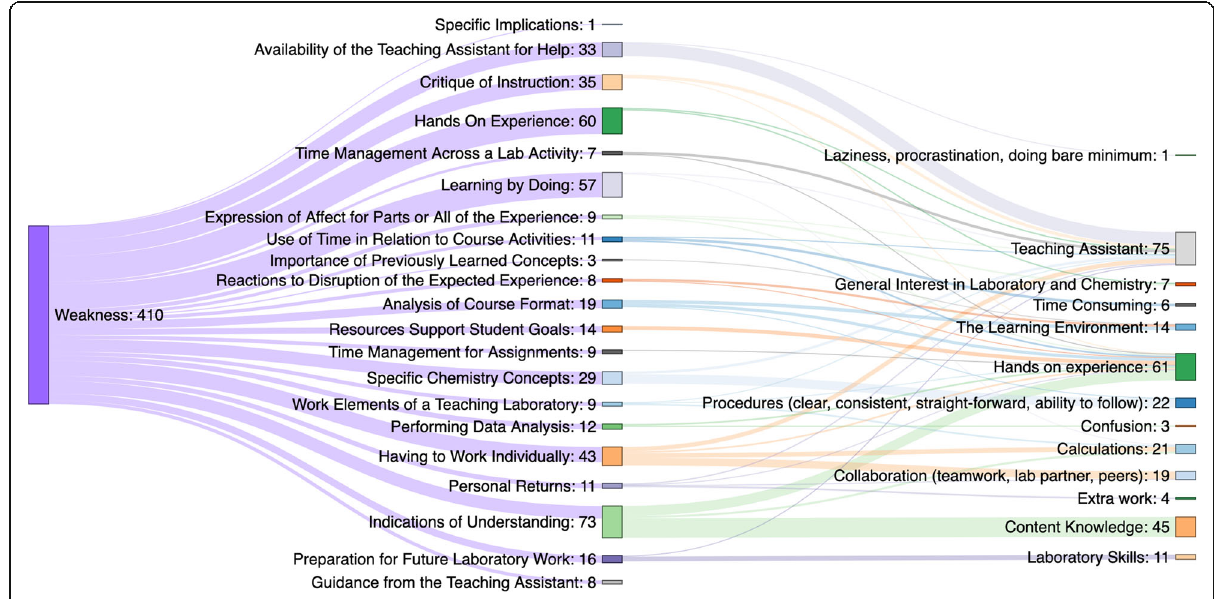
Fig. 4 Topic and dimensions for responses from URM participants regarding